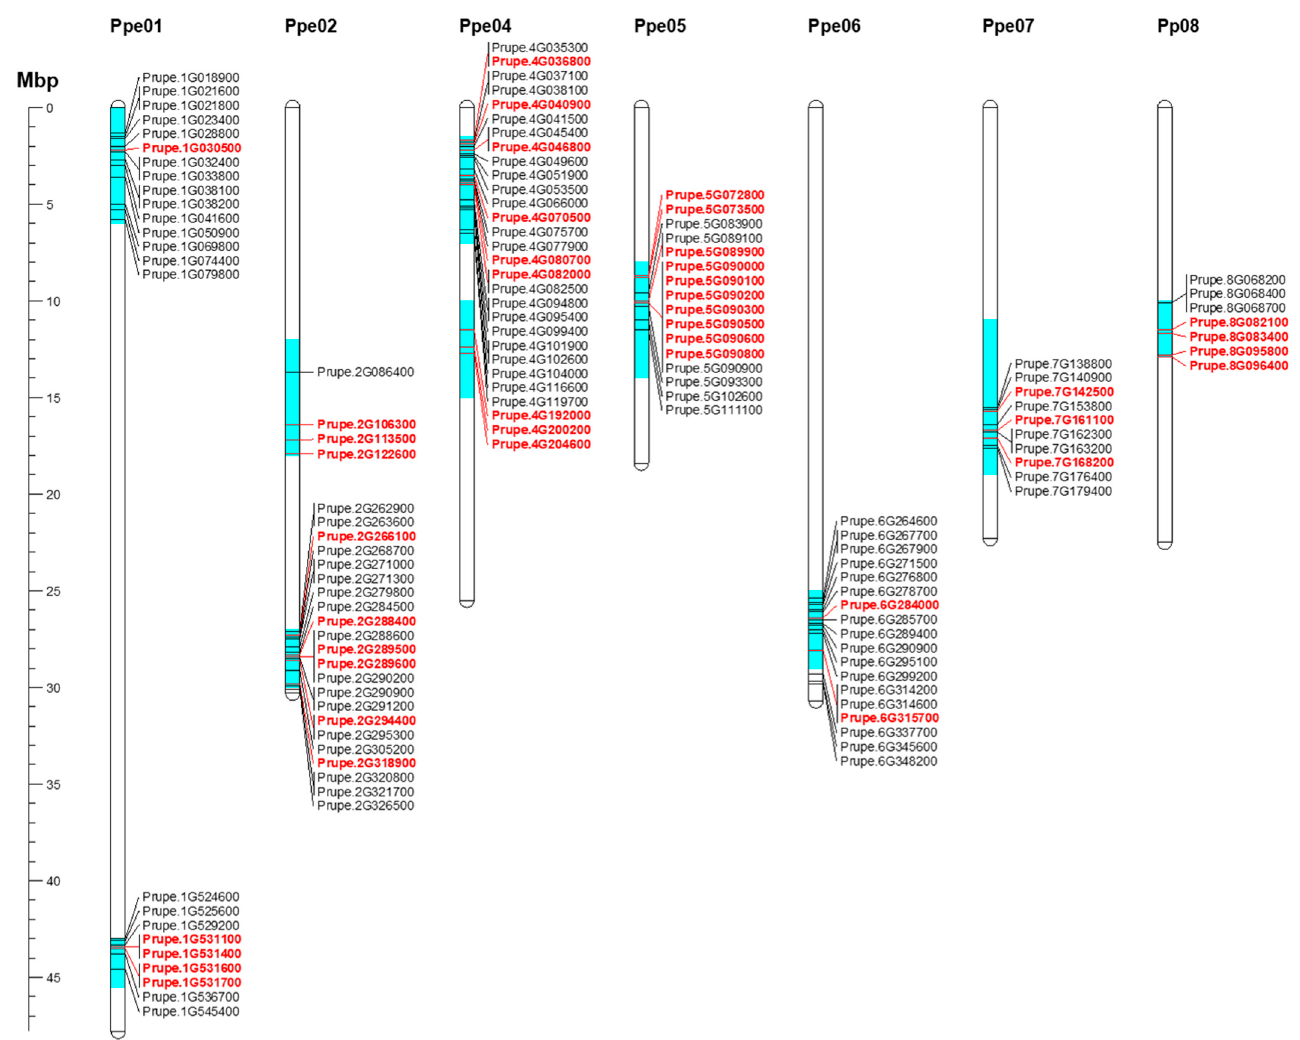
Figure 6. Mapping of candidate genes within major bloom time, chilling, and heat requirements QTLs on Prunus species [8,10–11,18–22,54–56]. Only differentially expressed genes during dormancy were considered for mapping in these QTL intervals. Genes highlighted in red show annotations related to dormancy control. Gene names were obtained from peach genome v2.0.a1 [57]. The scale represents the chromosomal position in megabase pair (Mbp).